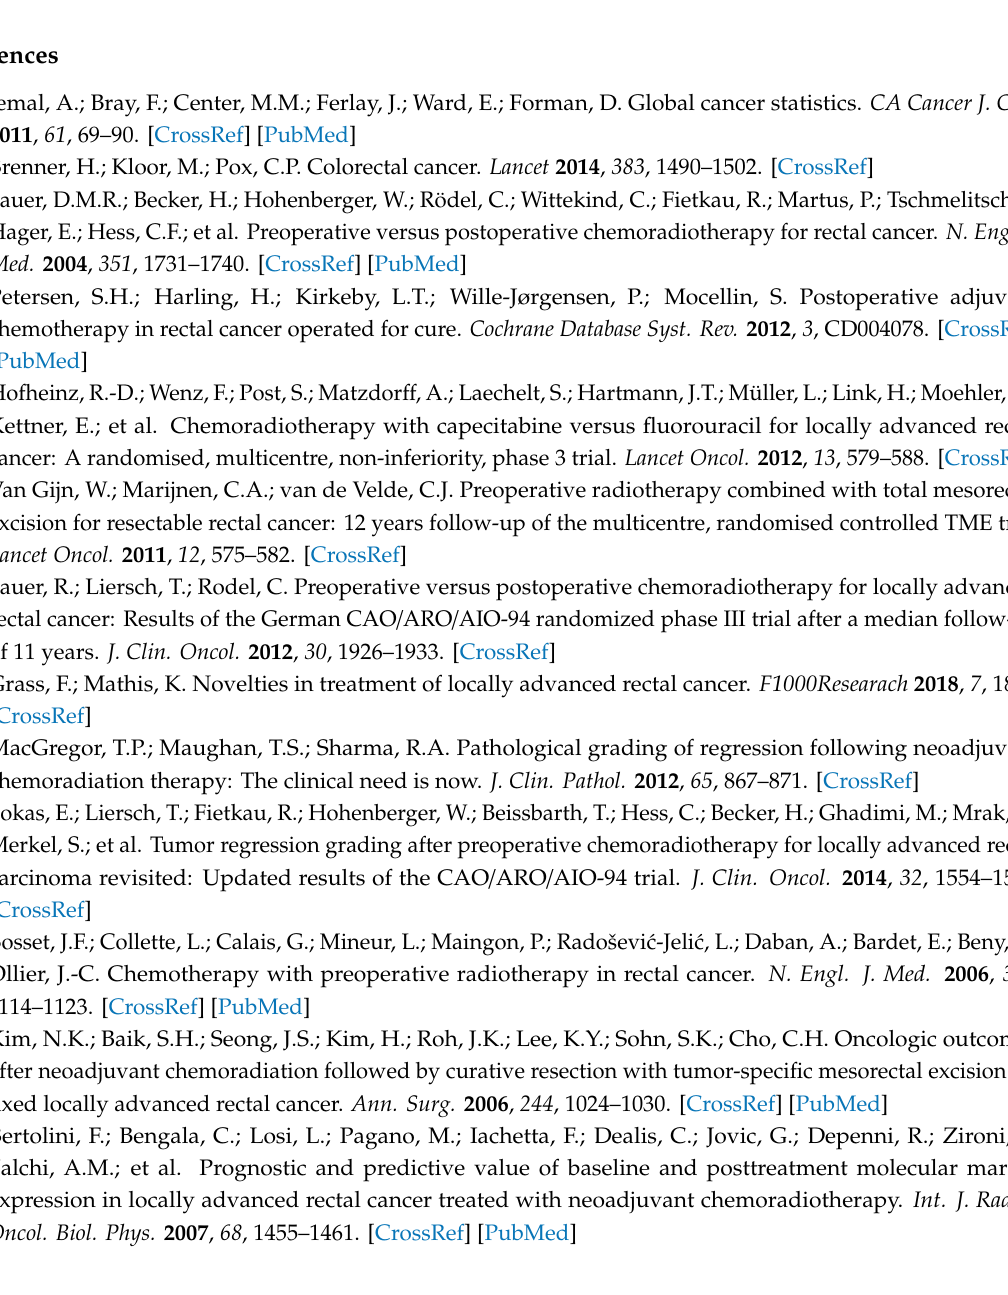
Figure S1: Controls for MTS and caspase 3 / 7 assays, Figure S2: Detailed information about SET analysis by western blot, Table S1: Association between mir-199b and clinical and molecular parameters in 110 LARC patients, Table S2: Association between mir-199b and tumor size / lymph node positivity in 82 LARC patients, Table S3: Association between miR-199b expression levels and downgrading in 60 LARC patients, Table S4: Association between SET and miR-199b expression in LARC patients, Table S5: Association between SET and pathological response to neoadjuvant CRT in LARC patients, Table S6: Association between miR-199b and immunohistochemical SET expression in LARC patients, Table S7: Univariate and multivariate Cox analyses for EFS in the cohort of 82 LARC